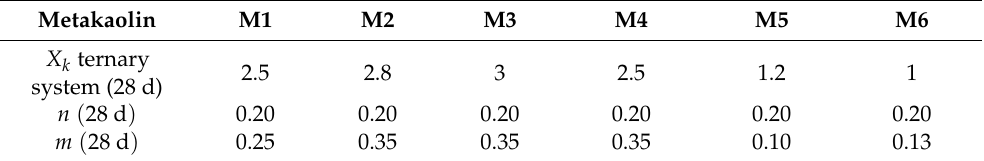
The activity factors 𝑋 (cid:3038) of the ternary system are higher than those obtained in the Table 11. Reactivity factors used to obtain both the equivalent binder concentration (Equation (2)) binary system. In the case of M1 and M3, the increase is significant, but it is much larger and the master curves in Figure 8. Reactivity factors n , m , k , l are obtained from the calculated in the case of M4, where the factor almost doubles from 1.3 to 2.5. The surface area of M4, porosity (Equations (4) and (5)) and the master curves in Figure 9. determined from rheological measurements, is also higher with the addition of the super-